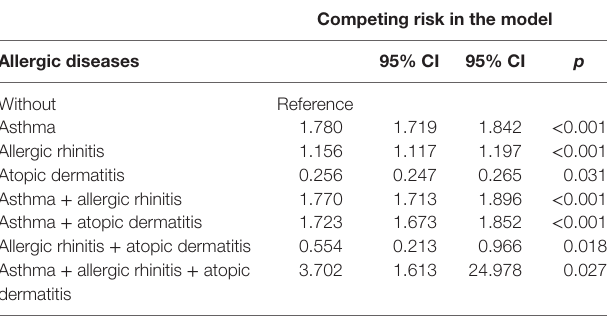
TaBle 5 | Factors of psychiatric disorders by using Cox regression and Fine and Gray’s competing risk model.